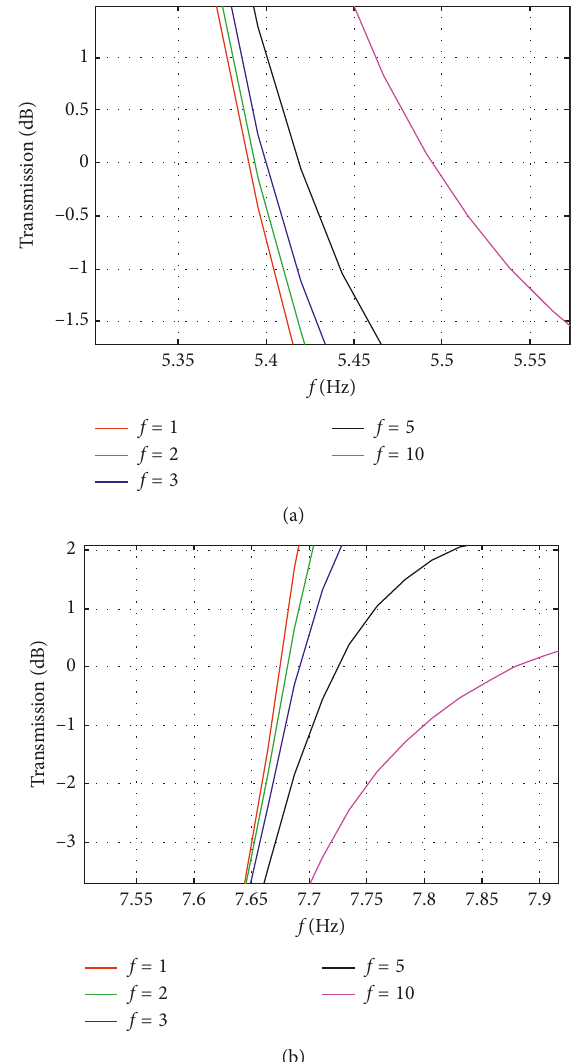
Figure 17: External excitation amplitude has changed the starting and cutoff frequencies. (a) Starting frequency region. (b) Cutoff frequency